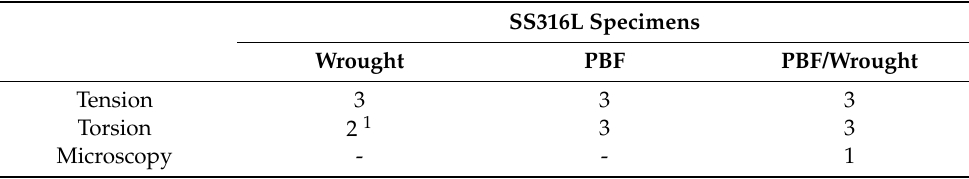
Table 1. Summary of test specimens.